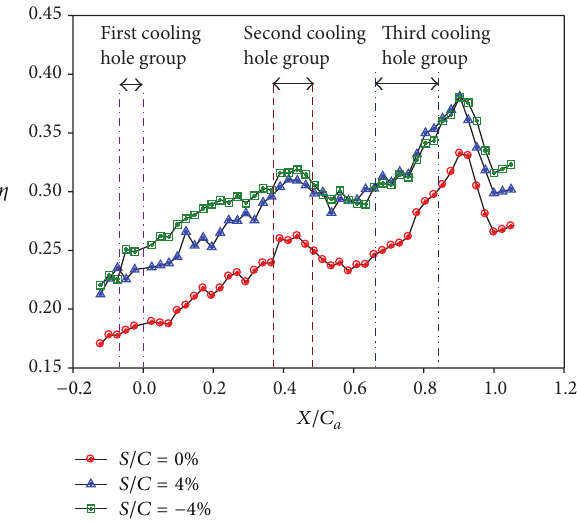
Figure 15: Effect of stepped endwall on averaged effectiveness at high turbulence intensity (Re = 124000 , 𝑀 = 1 , and T . I . = 12